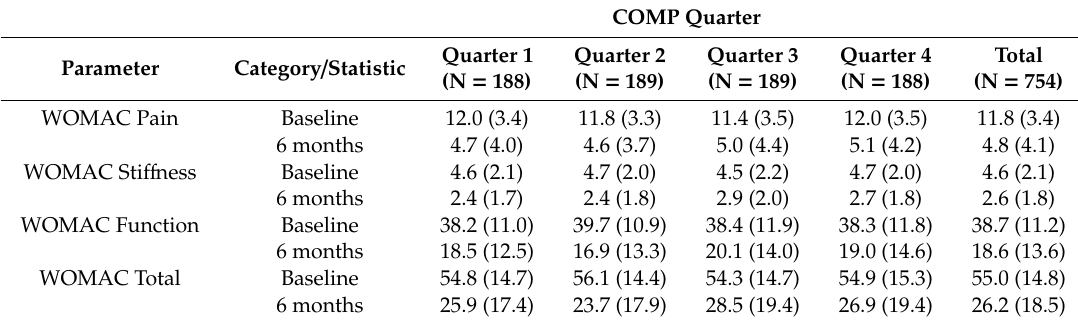
Table A2. Descriptive WOMAC Score (hip and knee OA) at baseline given as mean (SD). Multiple linear regression model adjusted for age, sex, BMI, and